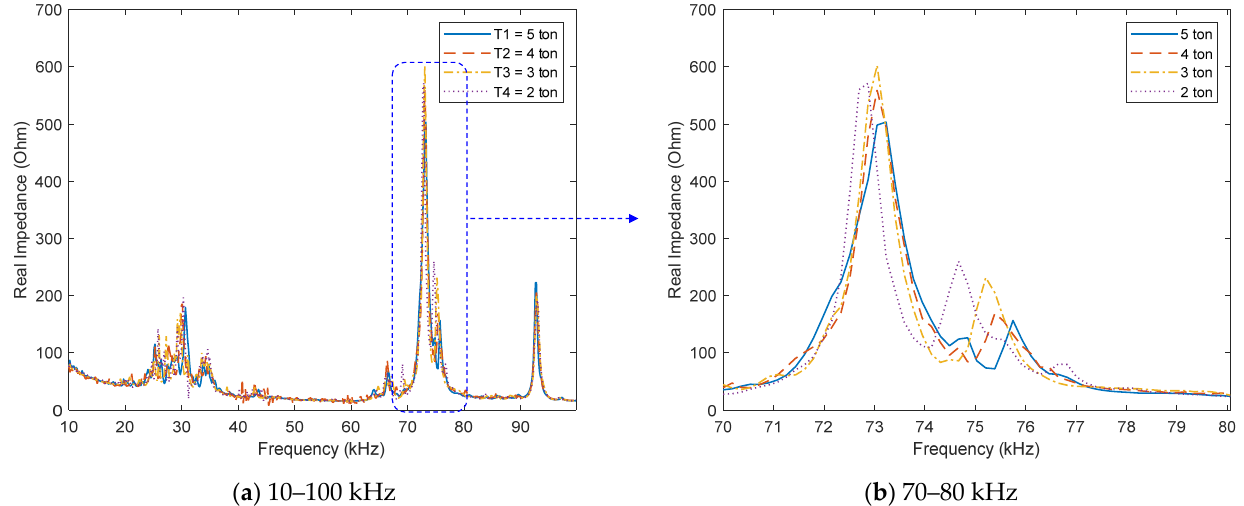
Figure 14. Real electromechanical impedance responses of the single-point mount PZT interface.